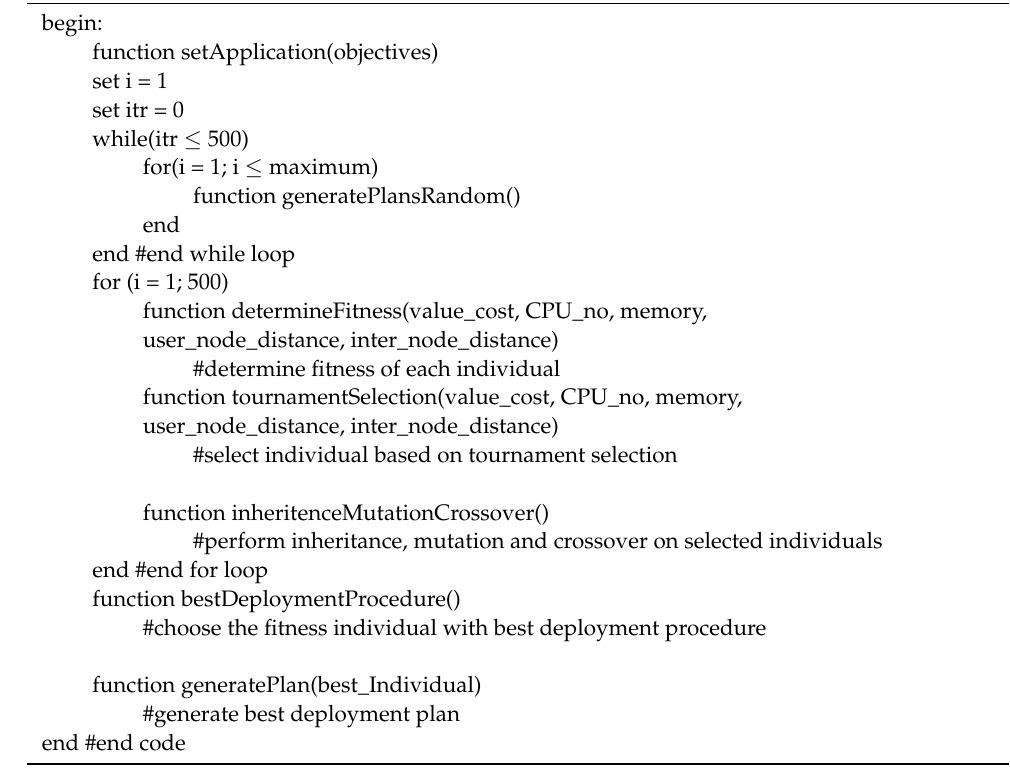
Algorithm 1. Optimizing